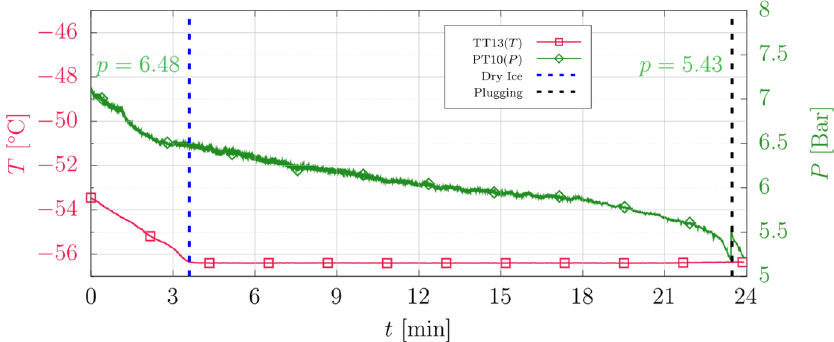
Figure 10. Pressure and liquid temperature in SV021 during Experiment 5. after expansion to the separation pressure in SV02 are given in Table 8. The experimental phase fractions (mol/mol) are based on mass flow and GC measurements. The TREND calculations predict lower vapor fractions than measured at all pressure levels. Table 8. Calculated values in TREND and experimental results for vapor, liquid, and solid phase fractions after expansion to the separation pressure in SV02. TREND Experimental Results